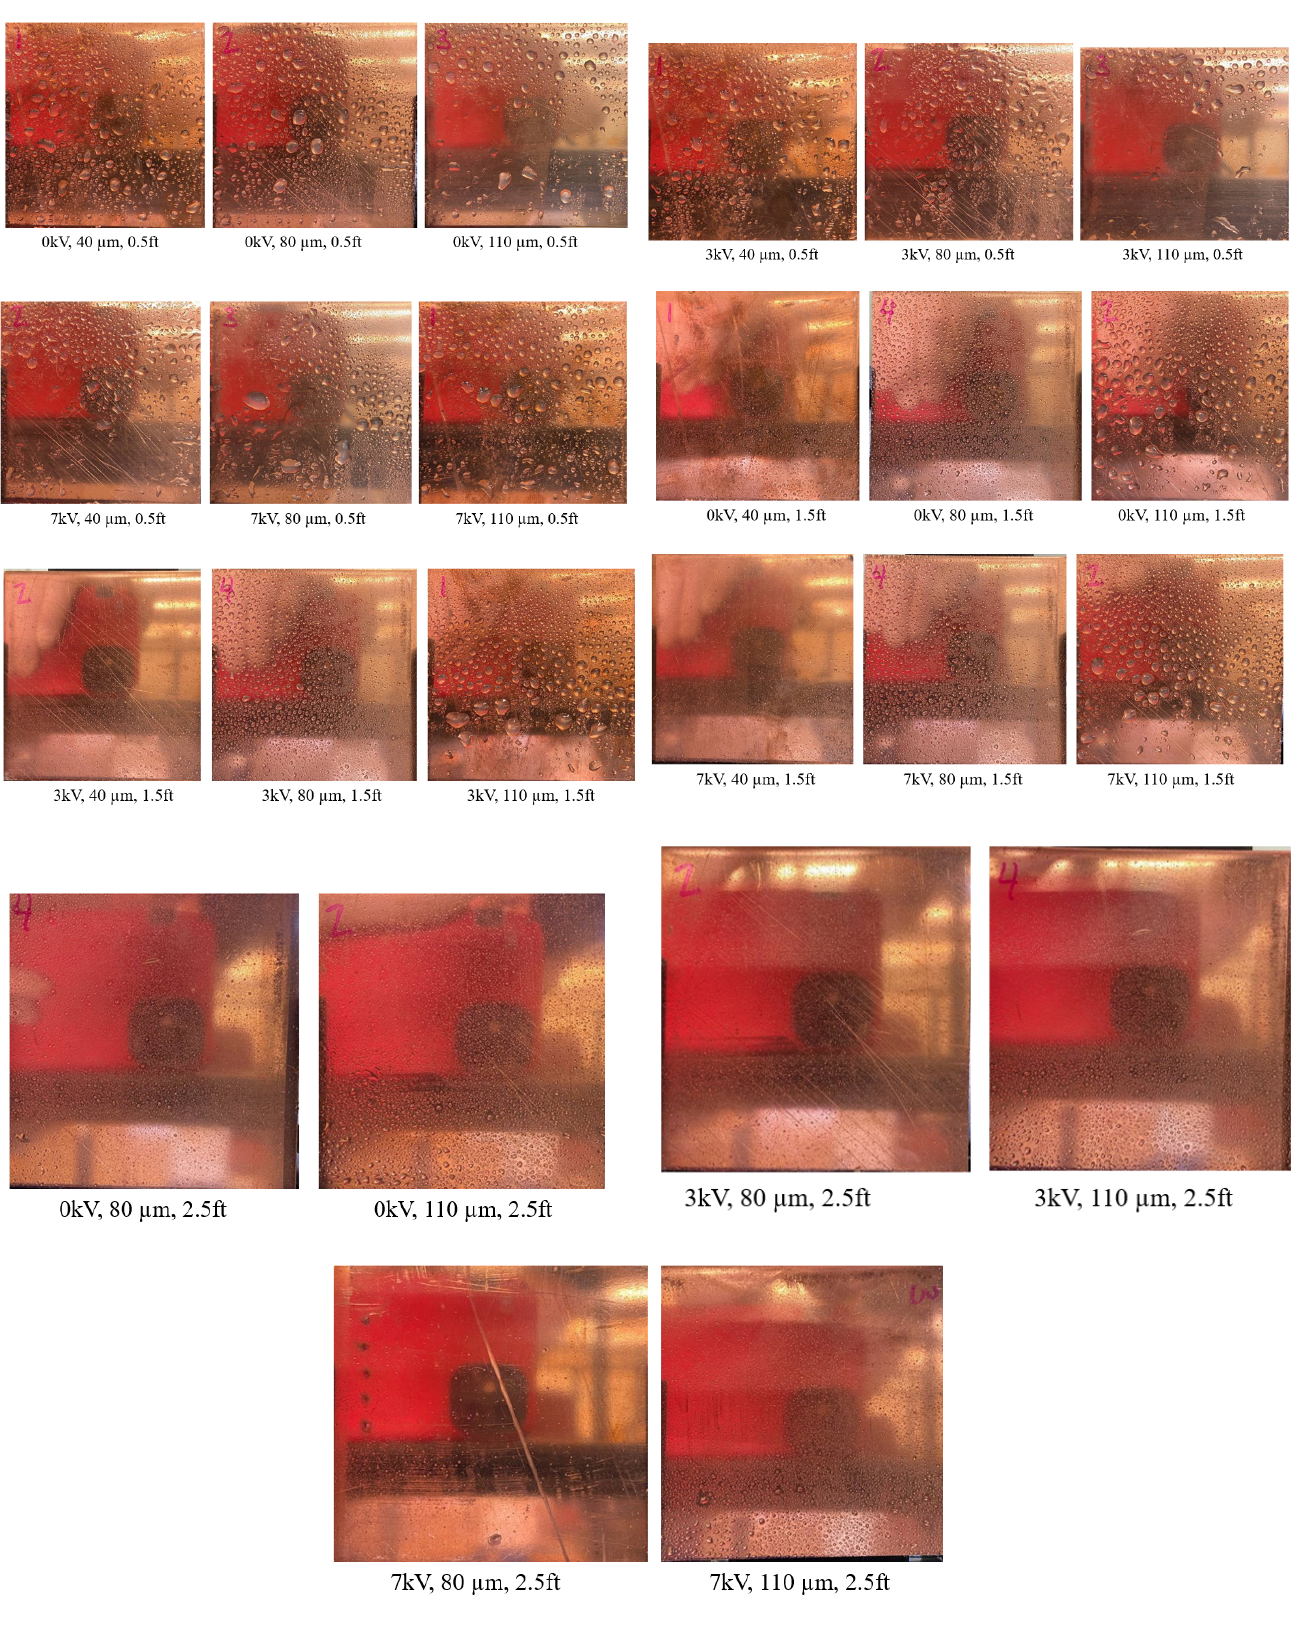
Figure A11. Copper: qualitative images of electrostatic deposition under various system